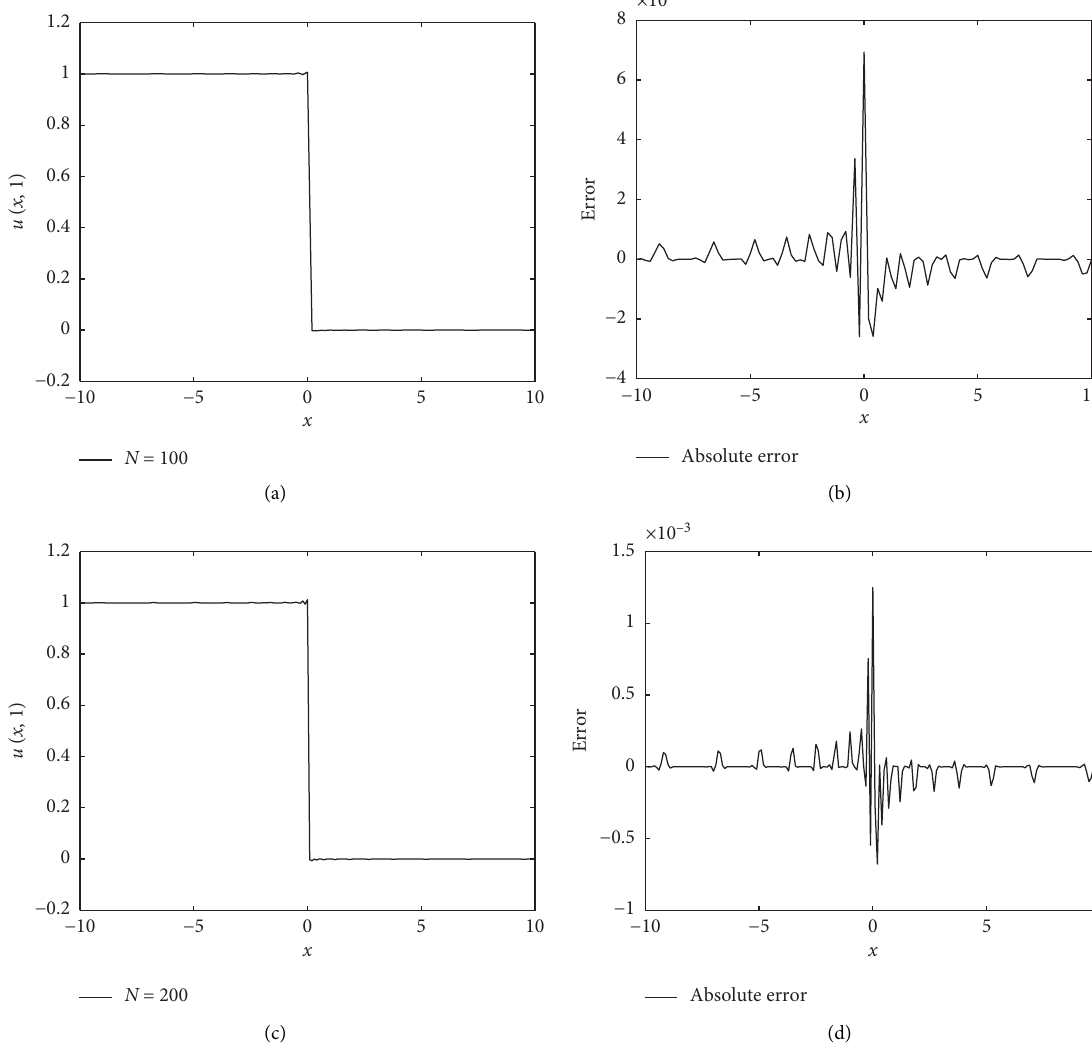
Figure 4: The numerical solutions and their absolute errors of Example 3 with α � 0 . 9and σ � 0 . 1 for different N at T � 1. (a) N � 100, (b) N � 100, (c) N � 200, and (d) N �